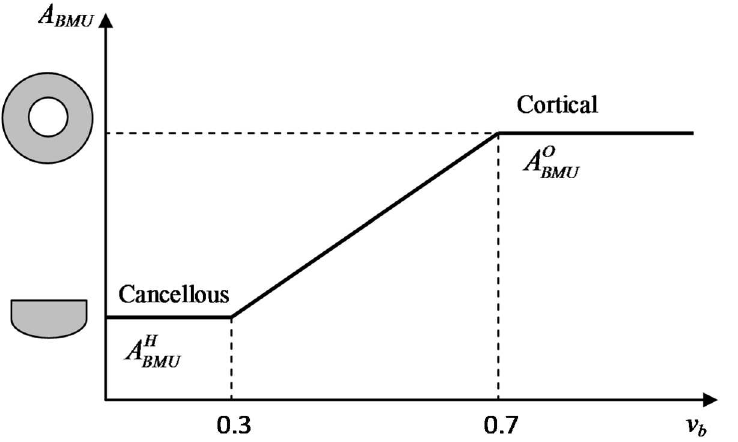
Fig 3. Cross section area ( A BMU ) of the tissue volume unit that a single BMU remodels in cortical and cancellous bone as a function of bone material volume. For v b > 0.7, osteonalcross section is considered whilefor v b < 0.3, hemi-osteonal cross section is used instead. For bone material volume values between0.3 and 0.7, a linear transition of cross section area is